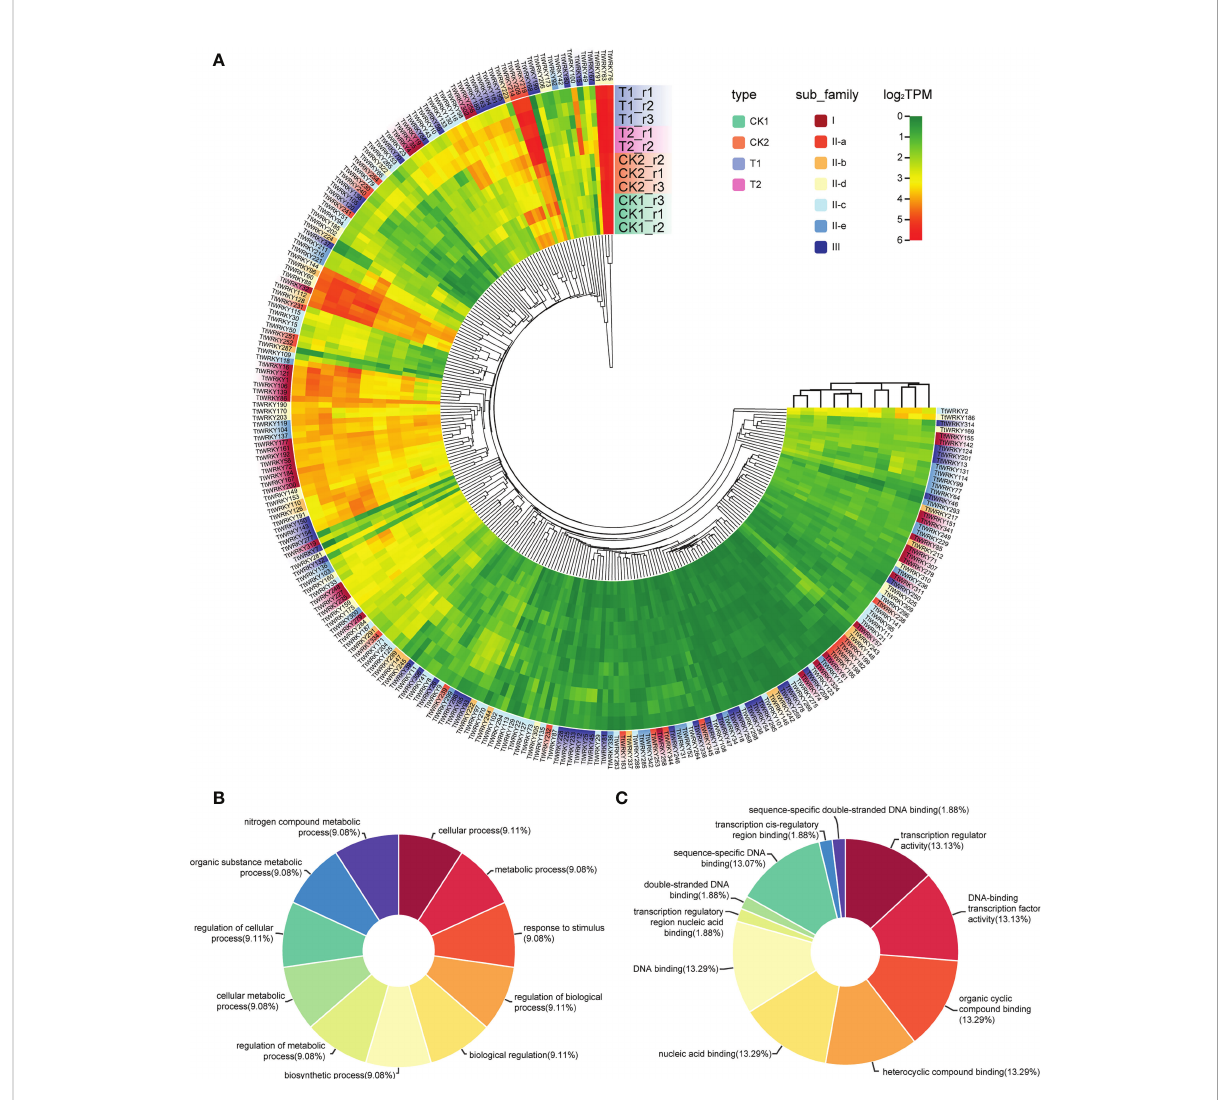
FIGURE 5 Expression patterns of TtWRKY genes under salt stresses and recovery treatments. (A) Hierachical clustering of expression pro fi les of 249 TtWRKY genes were expressed in 11 samples including salt stress and recovery treatment. (B, C) the BP (B) and MF (C) analysis of 249 expression